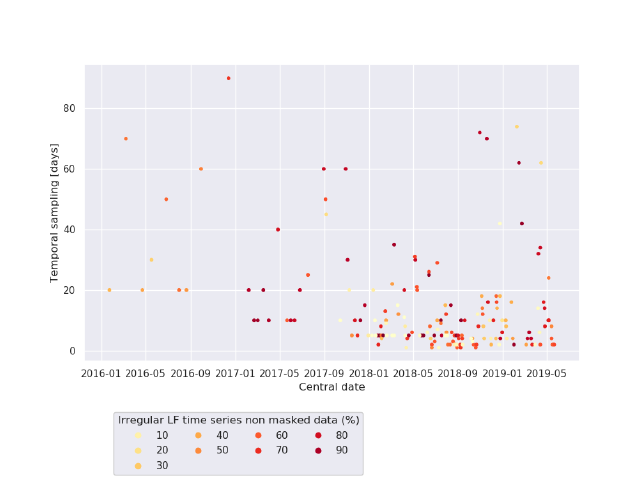
Figure 5. Temporal baselines of the Irregular Leap Frog time series according to their central date. The colormap indicates the percentage of non masked data for each temporal baseline and central